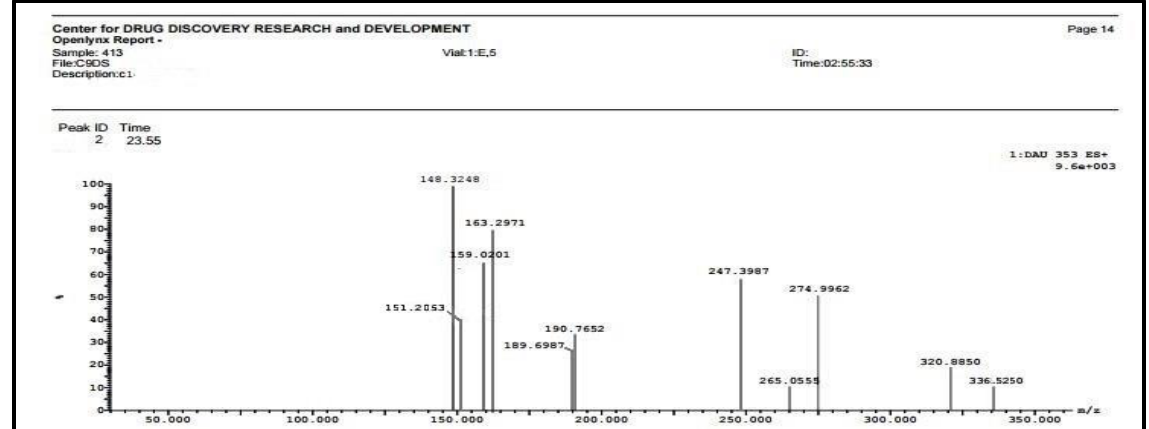
Figure13. Mass 2 fragmentation of protopine